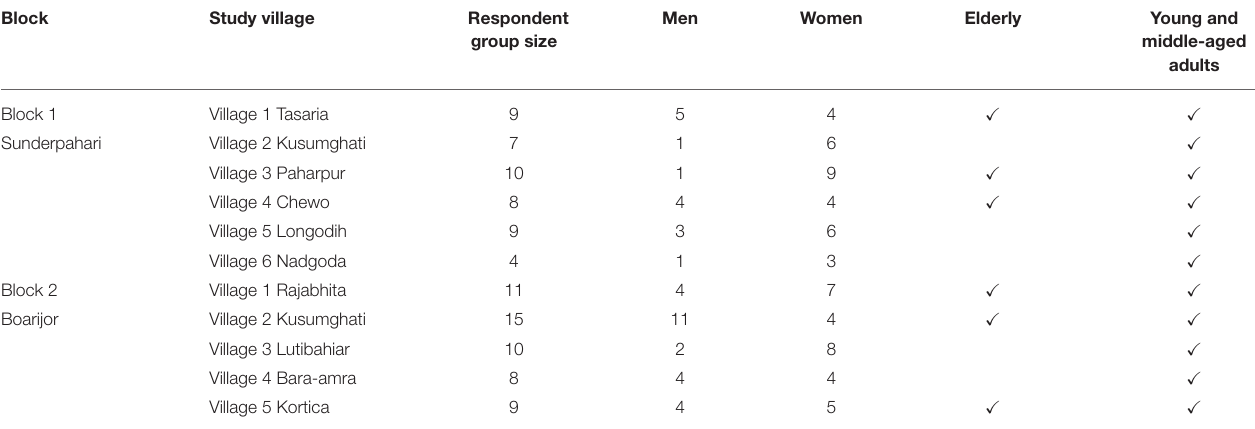
TABLE 1 | Characteristics of FGD respondents in villages of Sunderpahari and Boarijor blocks of Godda district, Jharkhand, India.